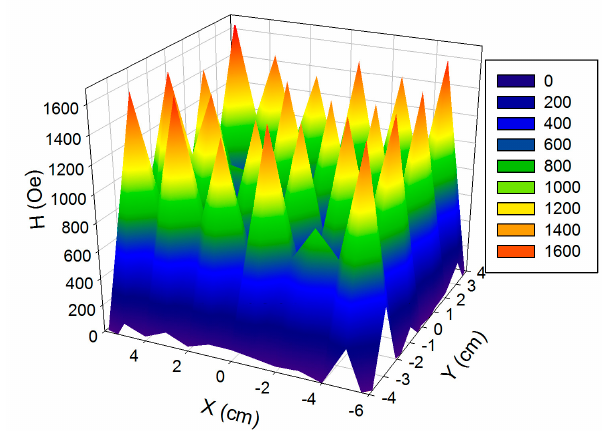
Figure 2. Magnetic field distribution created by the magnetic system in XY plane at Z = 0 cm.